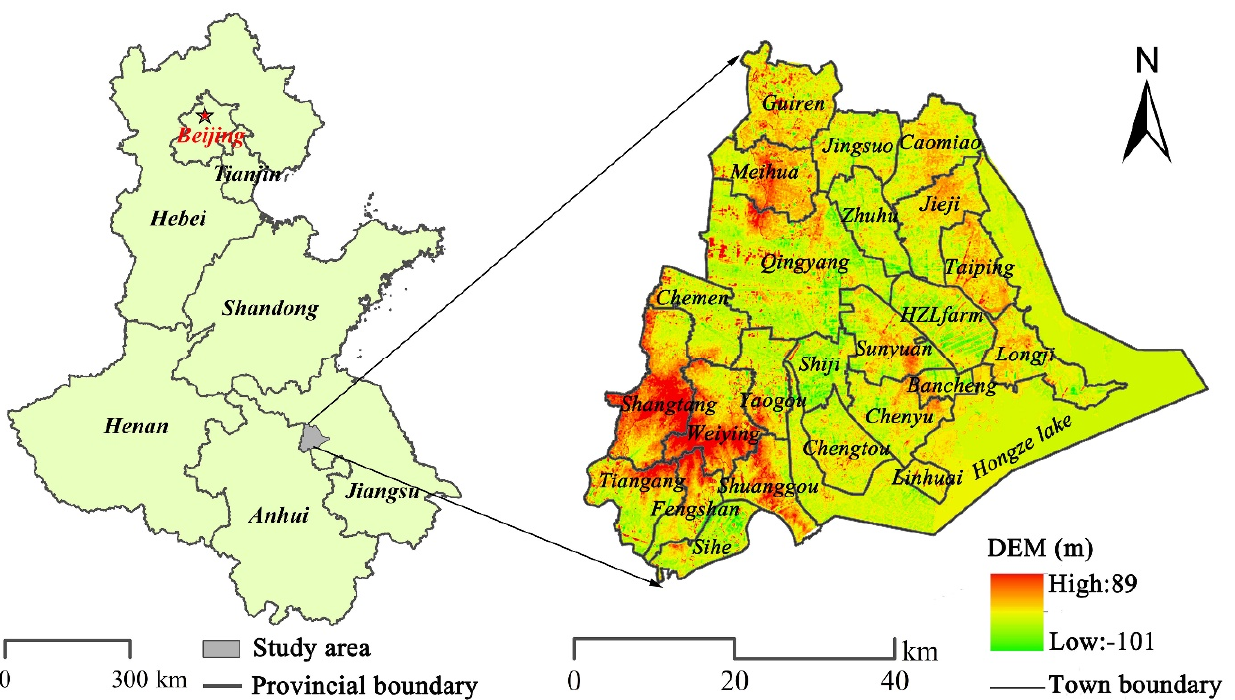
Figure 1. Location of Sihong County in the Huang-Huai-Hai Plain of China.